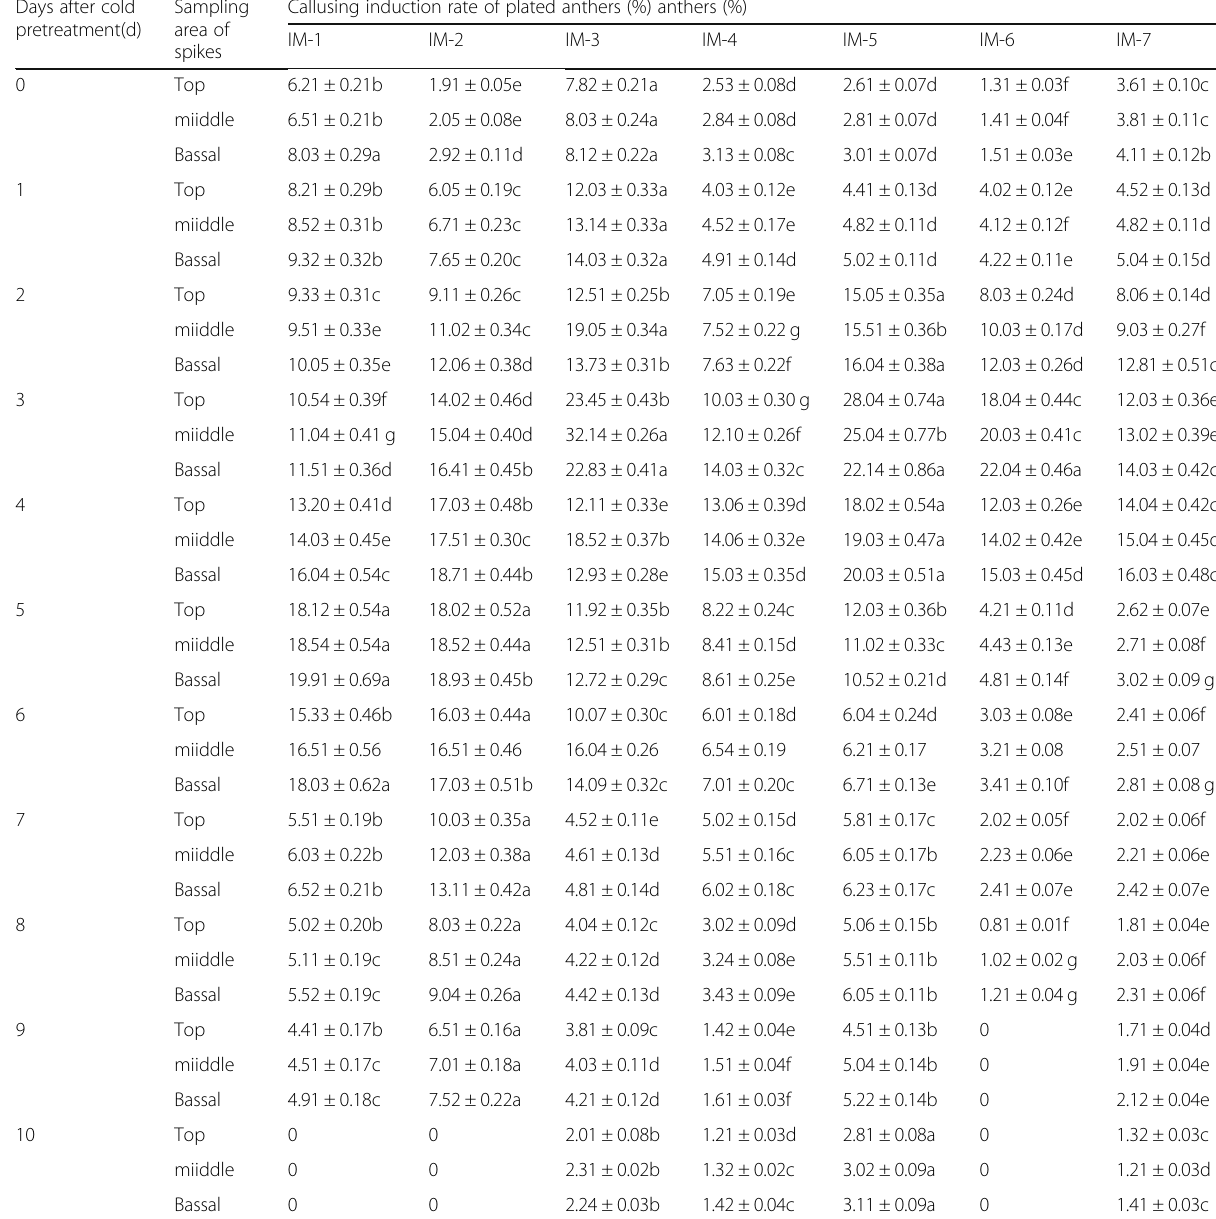
Table 2 Effects of different hormone components and treatment times on callus induction Days after cold Sampling pretreatment(d) area